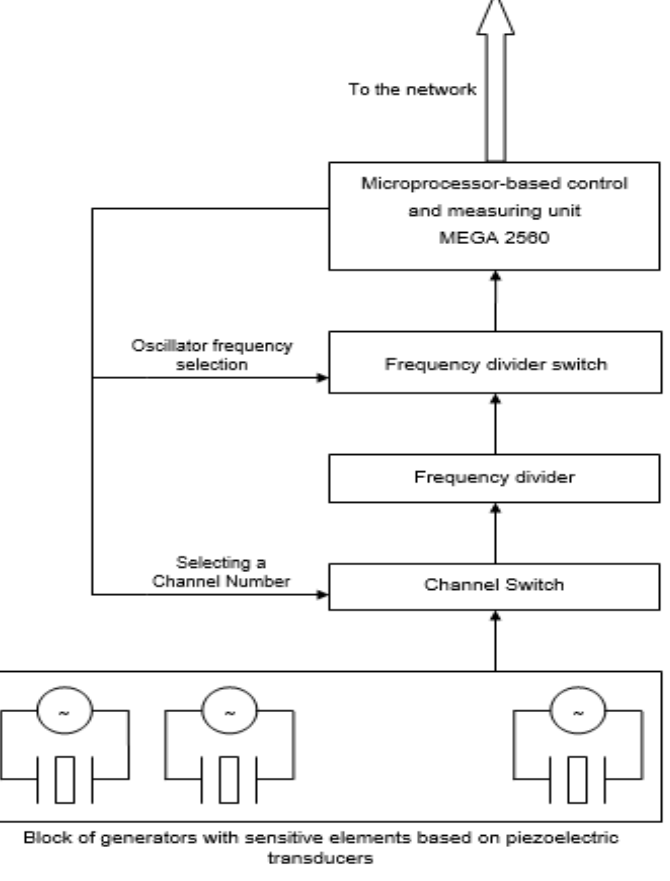
Figure 2. Block diagram of the registration module.